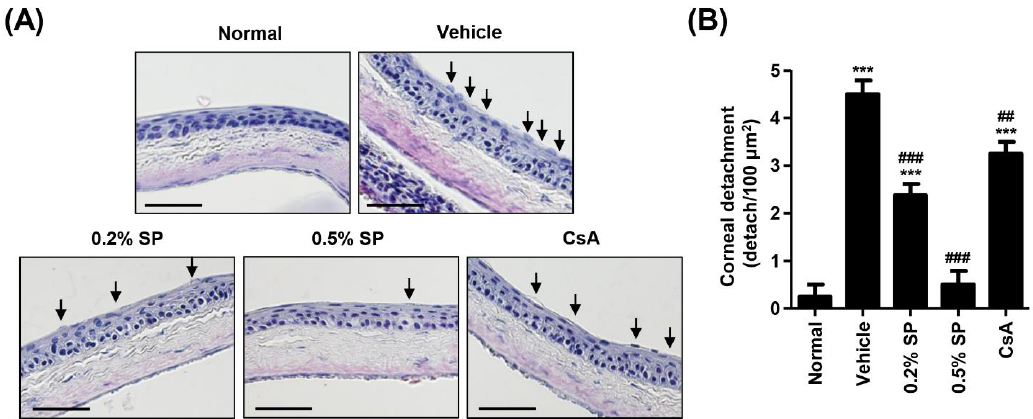
Figure 2. Effect of spermidine on the detachment of corneal epithelium in a rat model of PM 2.5 -induced dry eye diseases (DED). ( A ) Representative images of H&E-stained images of corneal sections. Black arrows indicate the detached and swollen epithelium. Scale bar; 50 μm. ( B ) The numbers of the detached corneal epithelium of 100 μm 2 in five different sections were counted. Each bar indicates mean ± standard deviation ( n = 5). The statistical analyses were conducted using analysis of ANOVA-Tukey’s post hoc test between groups. *** p < 0.001 compared to the normal group. ## p < 0.01 and ### p < 0.001 compared to the vehicle group.